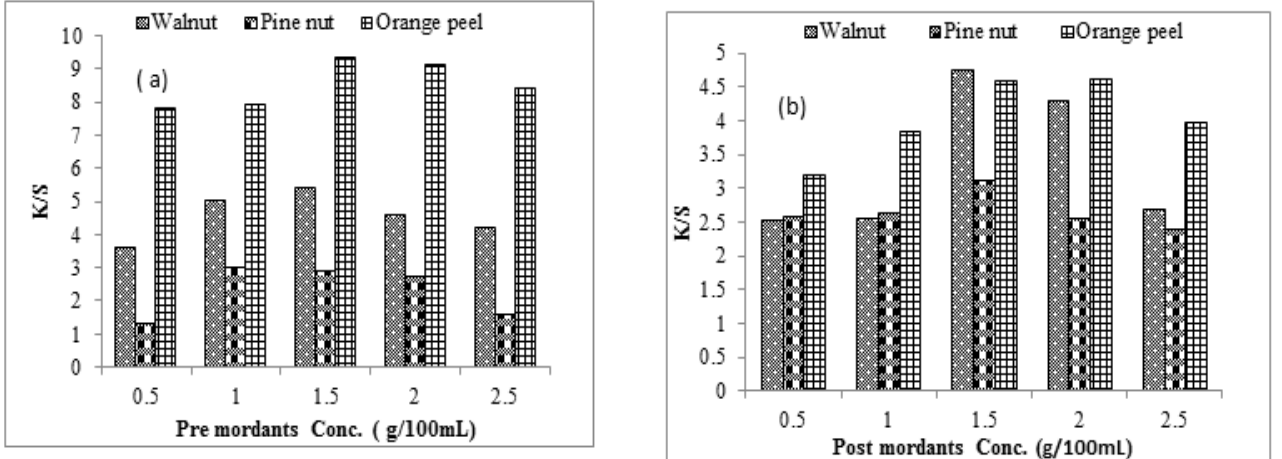
Figure 2. ( a ) Pre-bio-mordant of silk with black pepper extracts at optimized conditions. ( b ) Post-bio mordants of silk with black pepper extracts under selected conditions.